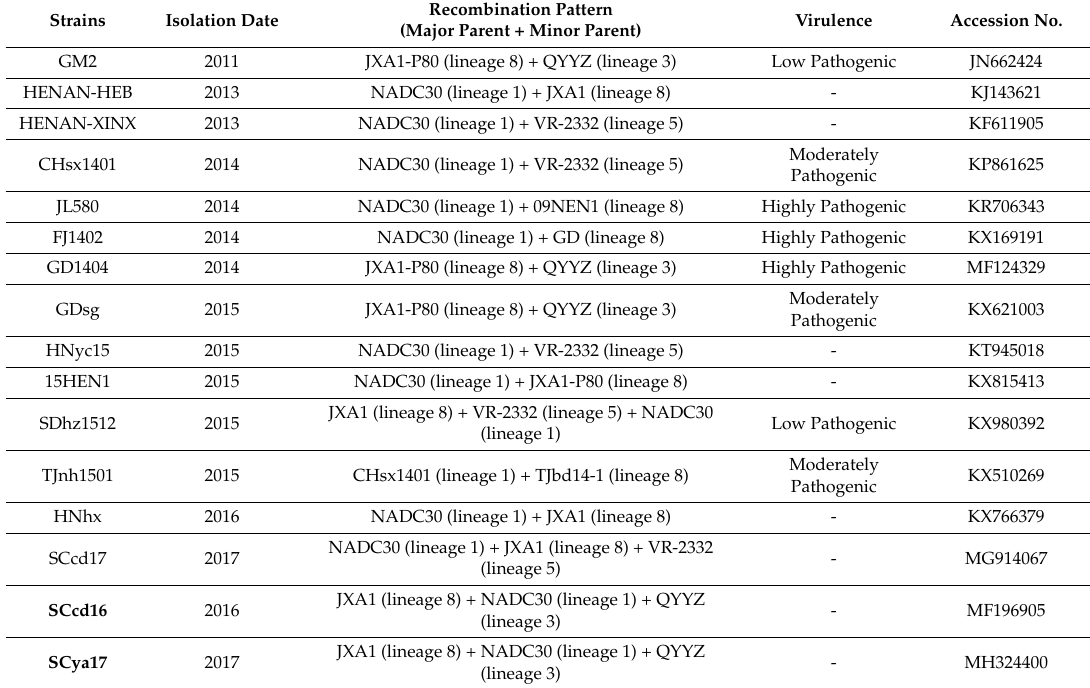
Table 3. Recombination analysis of PRRSVs isolated in China during